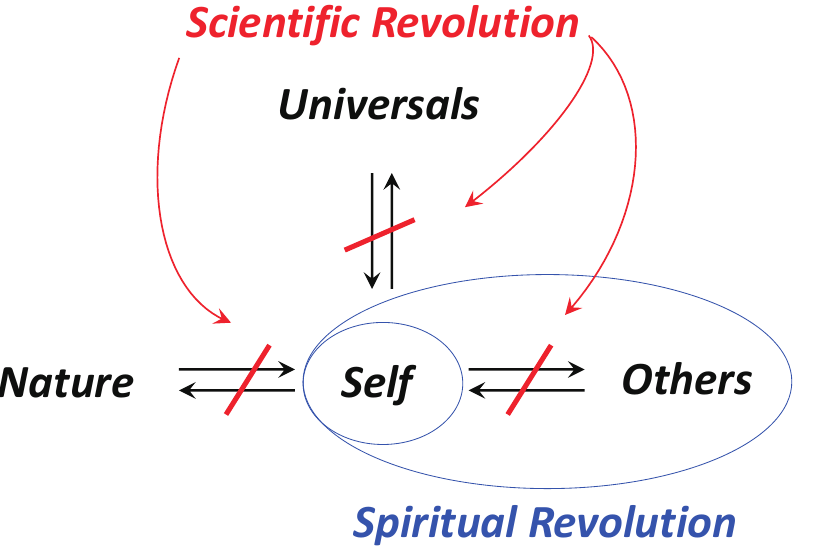
Figure 2. A schematic diagram, drawn based on Ito [1–4], of the structure of Scientific Revolution, where it has functioned as the principle to divide “humans from humans” and “humans from